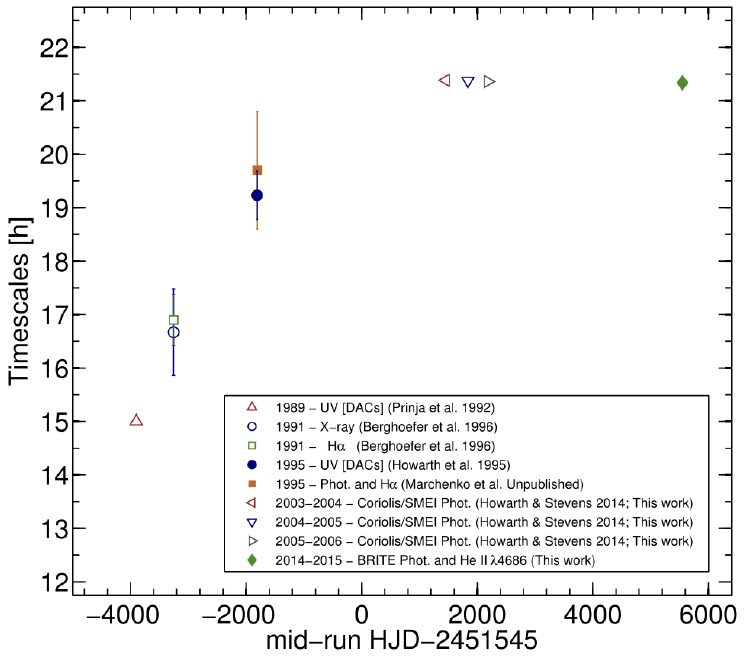
Figure 7. Periodicities potentially related to CIRs in ζ Pup as a function of time, based on observations in various modes (Figure 19 in Ramiaramanantsoa et al. 2018